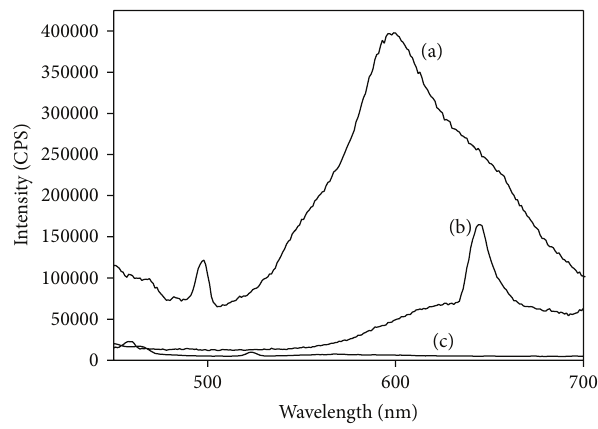
Figure 7: Fluorescence spectra of (a) HL 1 , (b) [Ni(L 1 ) 2 ], and (c) [Zn(L 1 ) 2 ] ⋅ H 2 O.